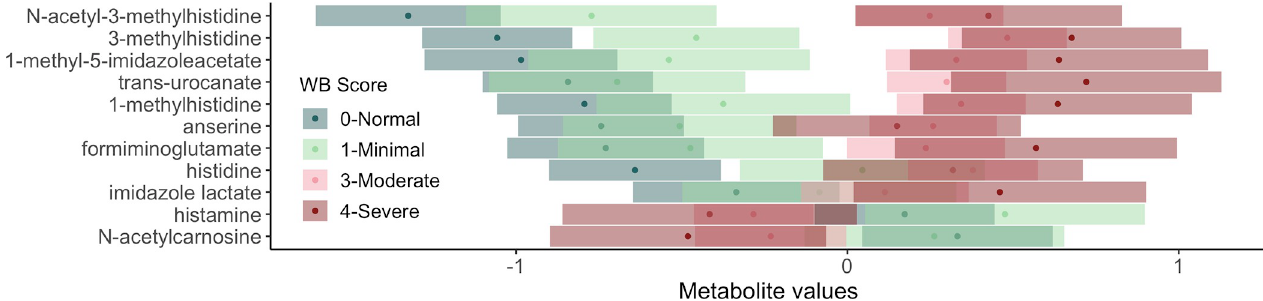
Fig 3. Association of wooden breast score with histidine metabolism in plasma of male broiler chickens. Results of post-hoc analysis of metabolite values by wooden breast score are shown with estimated marginal means (dots) and confidence intervals (bars). Overlapping confidence intervals indicate that there is no significant difference between the two scores. To improve visualization, metabolites are listed in order of the adjusted means for a wooden breast score of 0-Normal.